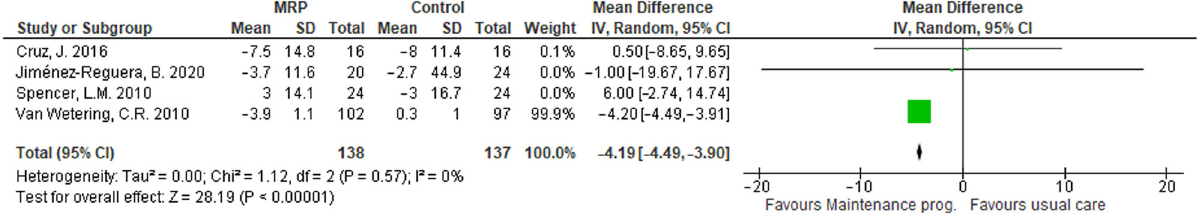
Fig. 6 Forest plot of MD in HRQoL with a maintenance PR